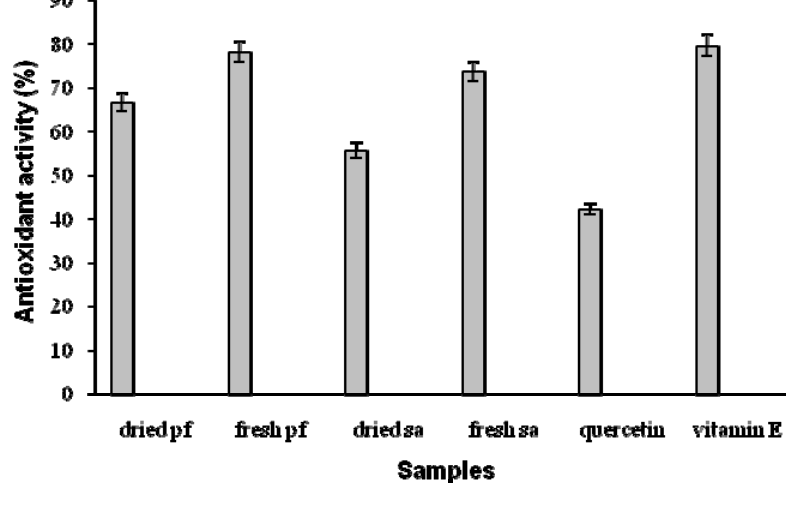
Figure 1 . Antioxidant activity of the different extracts and standard samples at 0.02 ppm in the β -carotene-linoleate system. Variations were significant at level